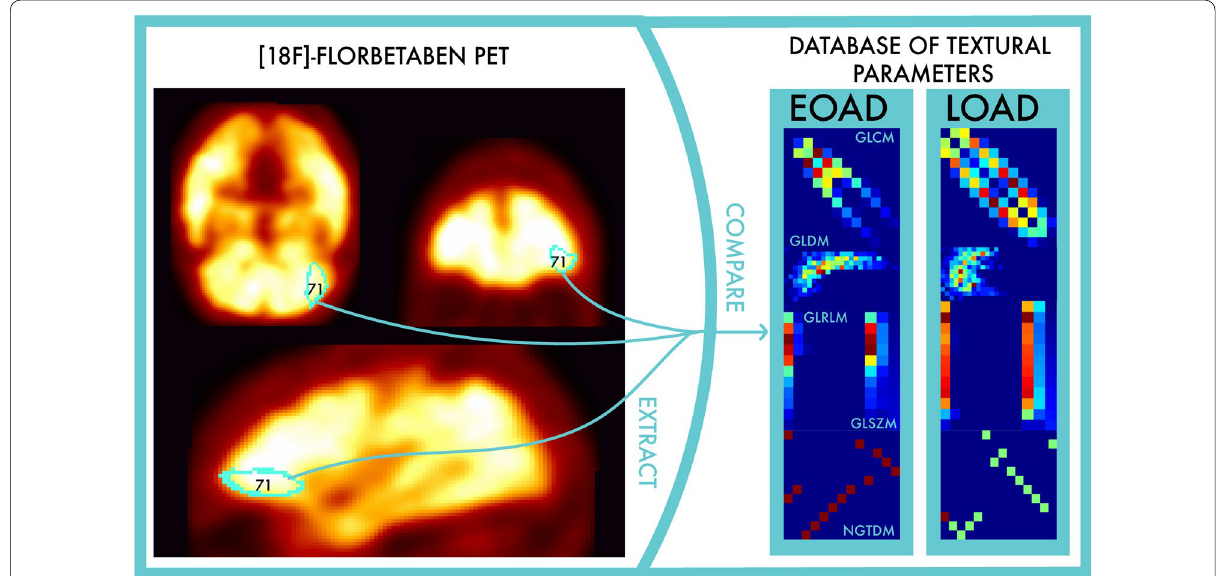
Fig. 7 Example of analysis in the lateral orbital gyrus, frontal lobe. Example of EOAD verification: the three-dimensional ROI corresponding to the right lateral orbital gyrus in the frontal lobe is extracted from the [ 18 F]florbetaben PET images, the textural parameters are calculated and compared with the database of patients collected in this paper, identifying EOAD